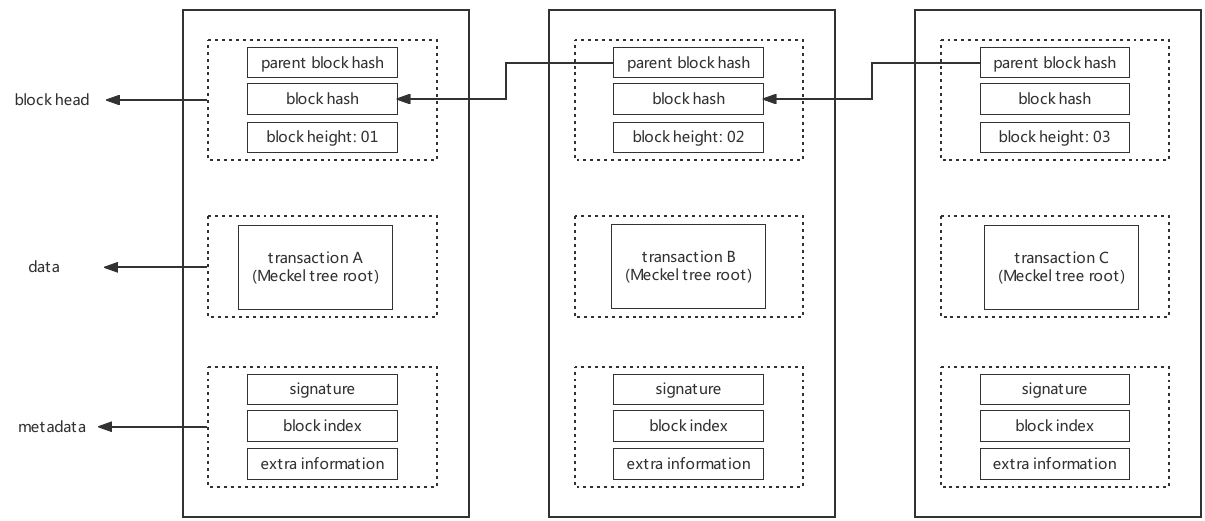
Figure 3. Diagram of the block structure of a simulated blockchain.